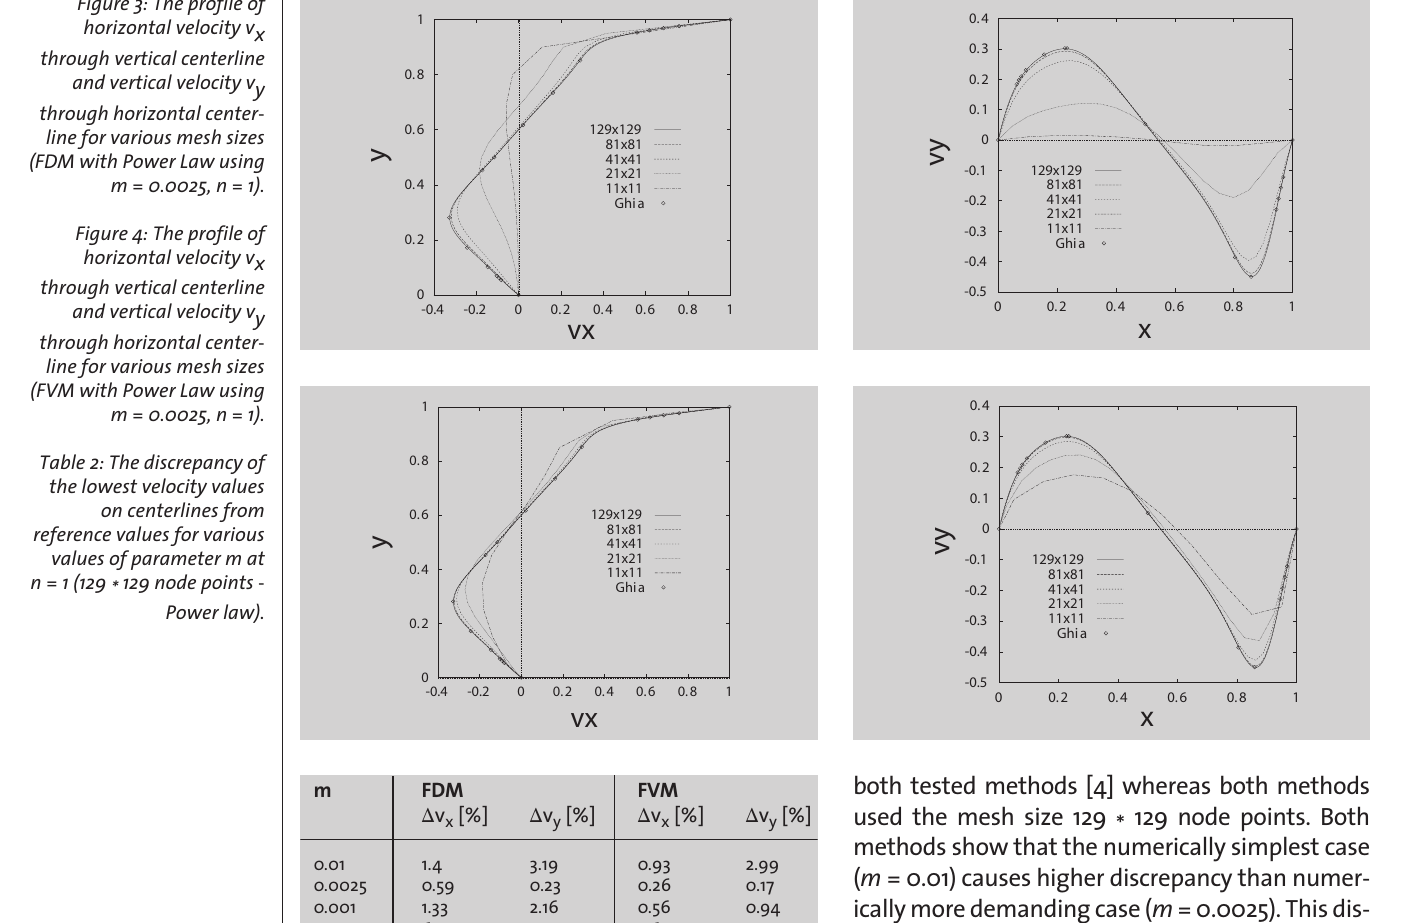
Figure 3: The profile of horizontal velocity vx through vertical centerline and vertical velocity vy through horizontal center- line for various mesh sizes (FDM with Power Law using m = 0.0025, n = 1). Figure 4: The profile of horizontal velocity vx through vertical centerline and vertical velocity vy through horizontal center- line for various mesh sizes (FVM with Power Law using m = 0.0025, n = 1). Table 2: The discrepancy of the lowest velocity values on centerlines from reference values for various values of parameter m at n = 1 (129 * 129 node points - Power law).